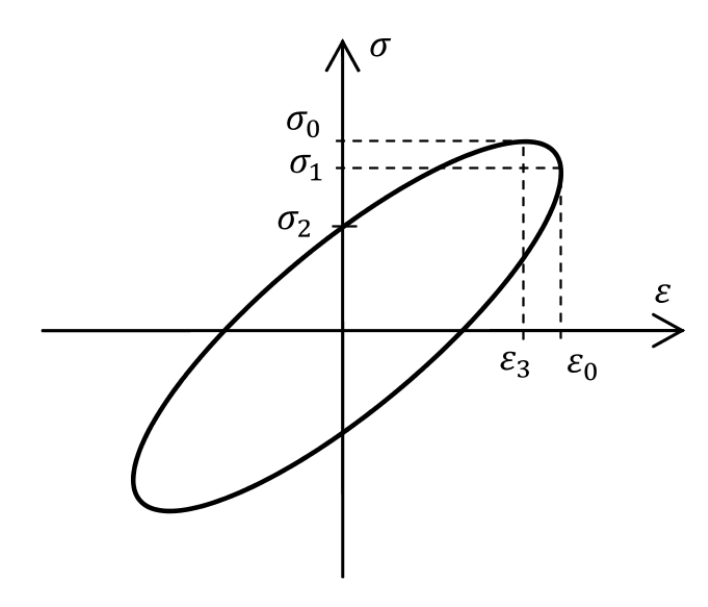
Figure 1. Example of hysteresis loop for VE material, stress–strain curve.